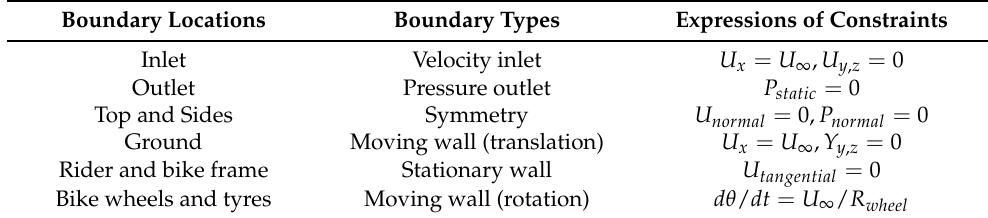
Figure 2. Schematic of the numerical domain showing dimensions and boundary settings. Table 2. Expressions of the constraints at the domain boundaries. Note the subscripts of normal and tangential refer to the quantities in the normal and tangential direction of the boundaries, R wheel refers to the radius of the